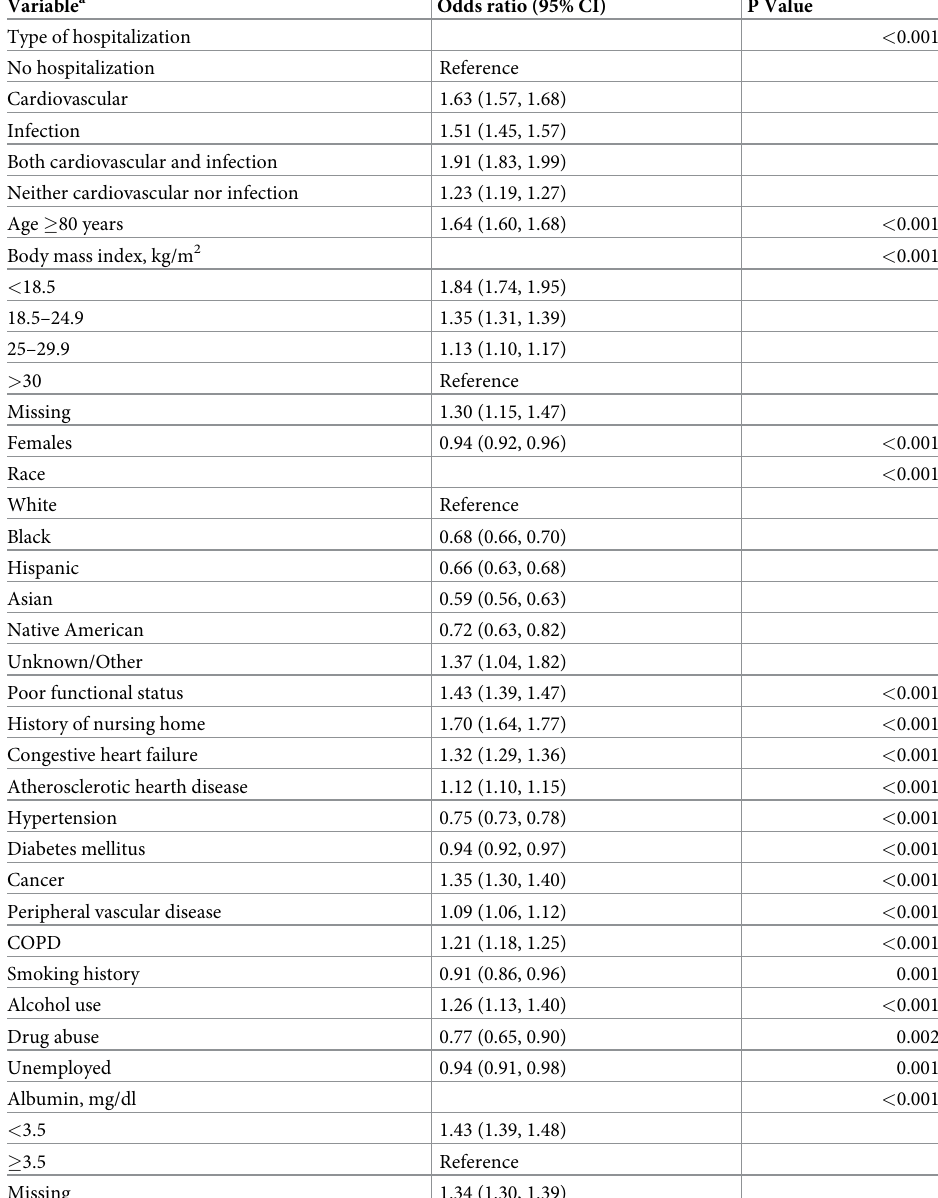
Table 2. Independent variable predictors of 1-year mortality in the final regression